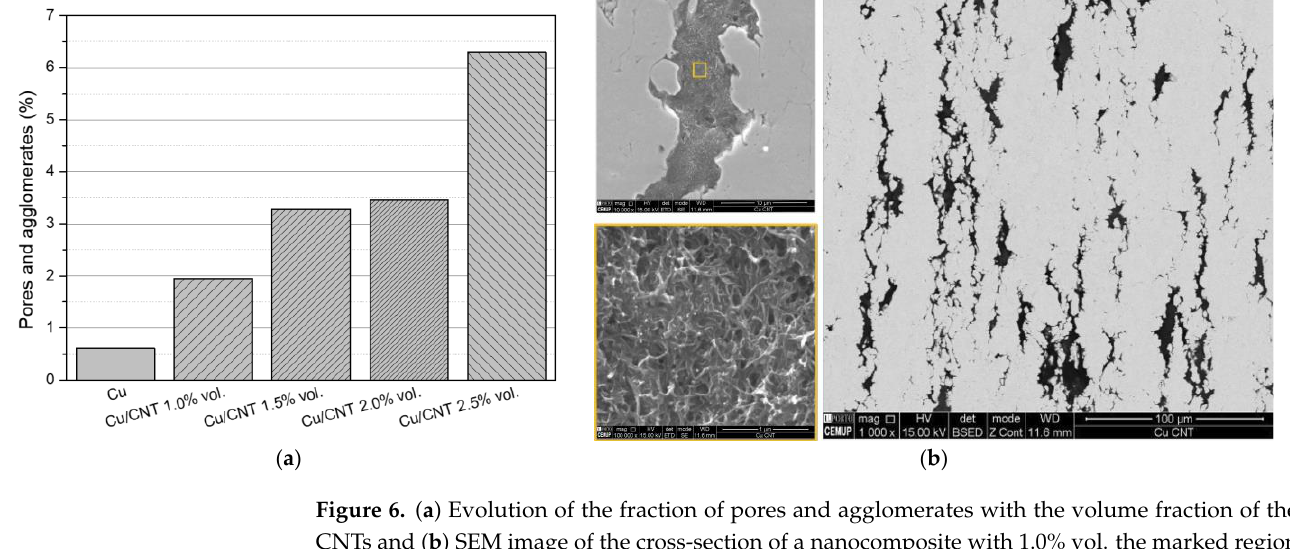
Figure 6. ( a ) Evolution of the fraction of pores and agglomerates with the volume fraction of the CNTs and ( b ) SEM image of the cross-section of a nanocomposite with 1.0% vol. the marked region in the figure represents the magnified area showing the CNTs.